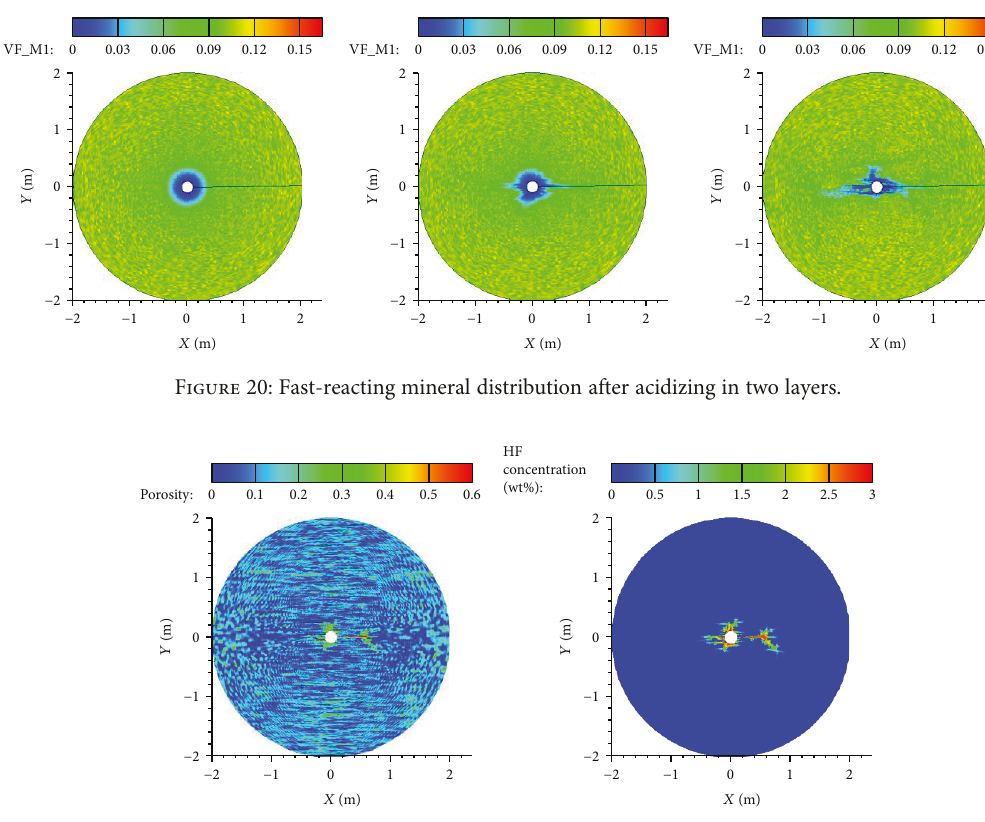
Figure 21: Porosity and acid concentration distribution when a fracture connects to the